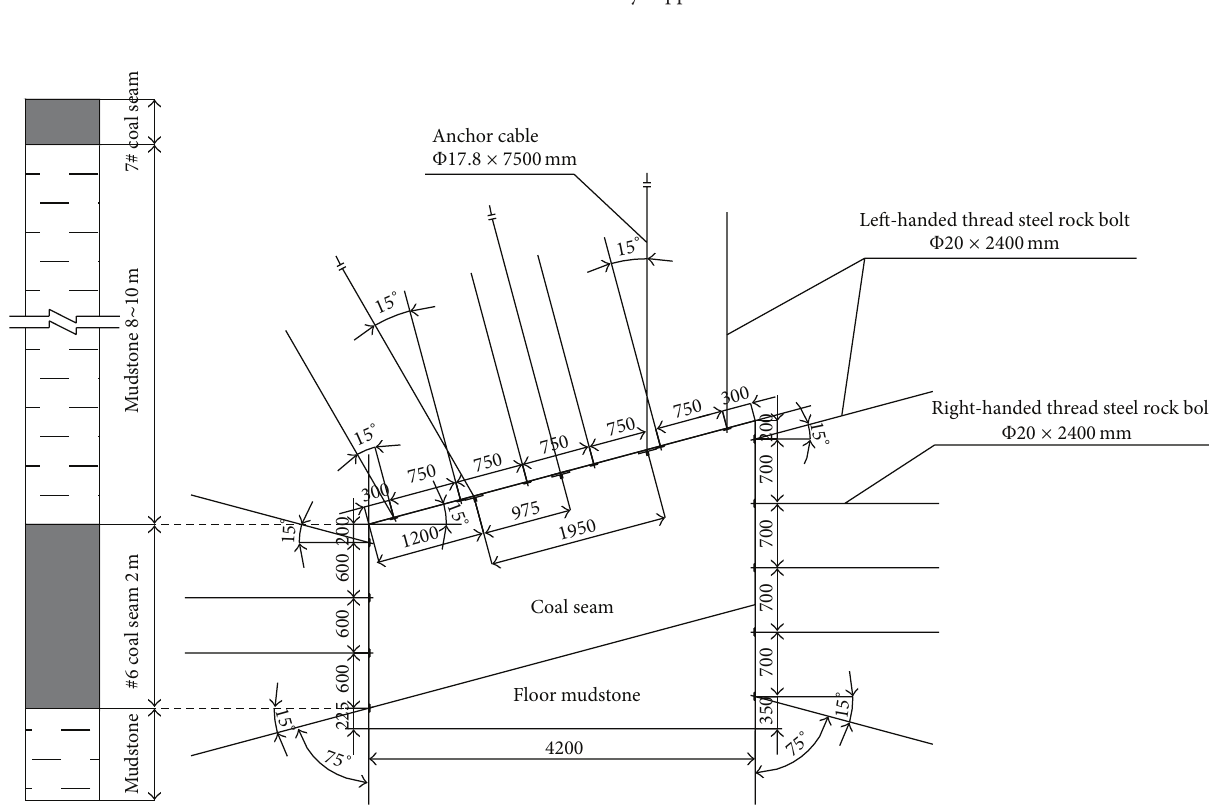
Figure 15: Preliminary support scheme.